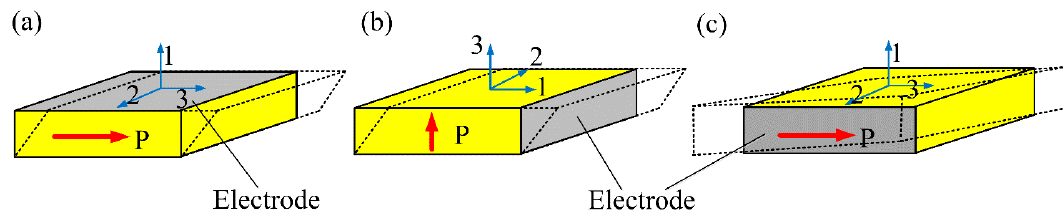
Figure 1. Definition of different shear mode piezoelectric wafers: ( a ) conventional in ‐ plane poled thickness ‐ shear d 15 mode; ( b ) thickness ‐ poled thickness ‐ shear d 15 mode; ( c ) face shear d 24 mode.